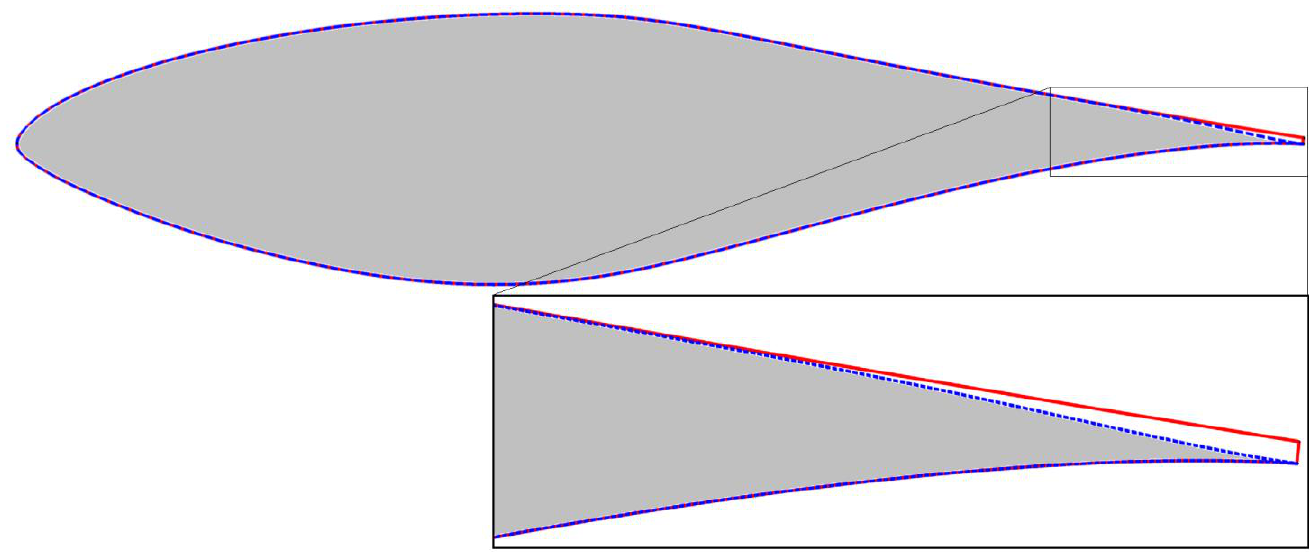
Figure 1. Original (blue) and modified airfoil shape (red) used for geometric model construction. A close-up of the altered portion close to the trailing edge is presented.